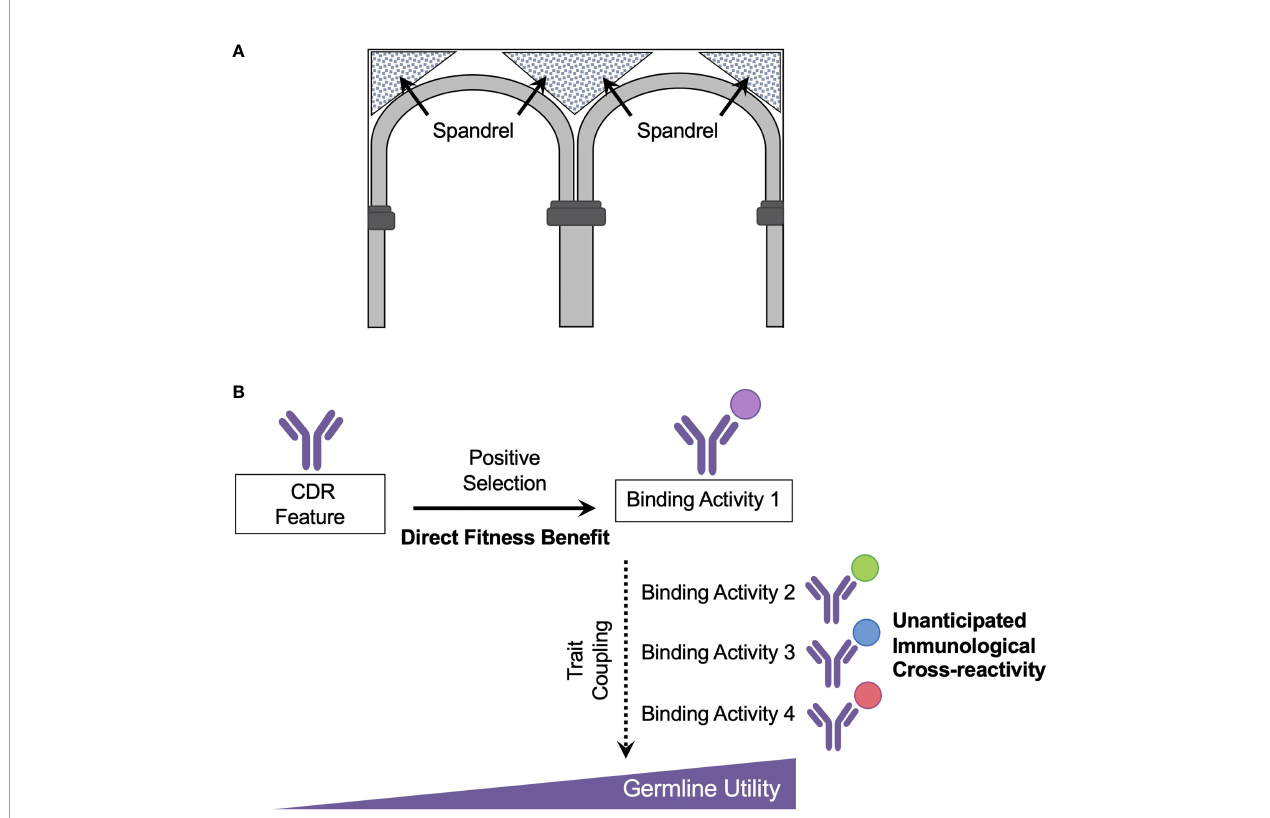
FIGURE 2 | Recognition of new antigen as an evolutionary spandrel (A) A spandrel isan architectural by-product formed byadjacent rounded arches within a rectangular frame. (B) Germline antibody reactivity and utility isproposed to emerge as a set of spandrels or secondary ‘ unintended ’ consequences of positive selection on the germline antibody repertoire. In this scheme, the antibodyrepertoire was initially shapedby positive selection for combating disease-causing pathogens. A key evolutionary adaptation inthis process was the development of recombinatoriallymphocyteimmune receptors, which appeared in vertebrates ~500 mya ago. However, germline antibody reactivity to new,different, antigen cannot beconsidered as an evolutionaryadaptation unless they result in an increase in inclusive fi tness. Rather the capacity for reactivity to novel antigen (hen egg lysosome, ovalbumin, vaccine antigens) ismore appropriatelyframedas spandrelsorunanticipated biproducts of the primary adaptations which